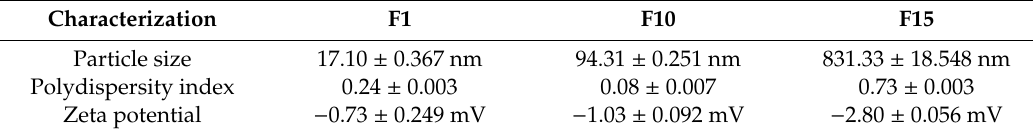
Table 2. The characterization of Grade A self nano-emulsifying drug delivery system (SNEDDS).